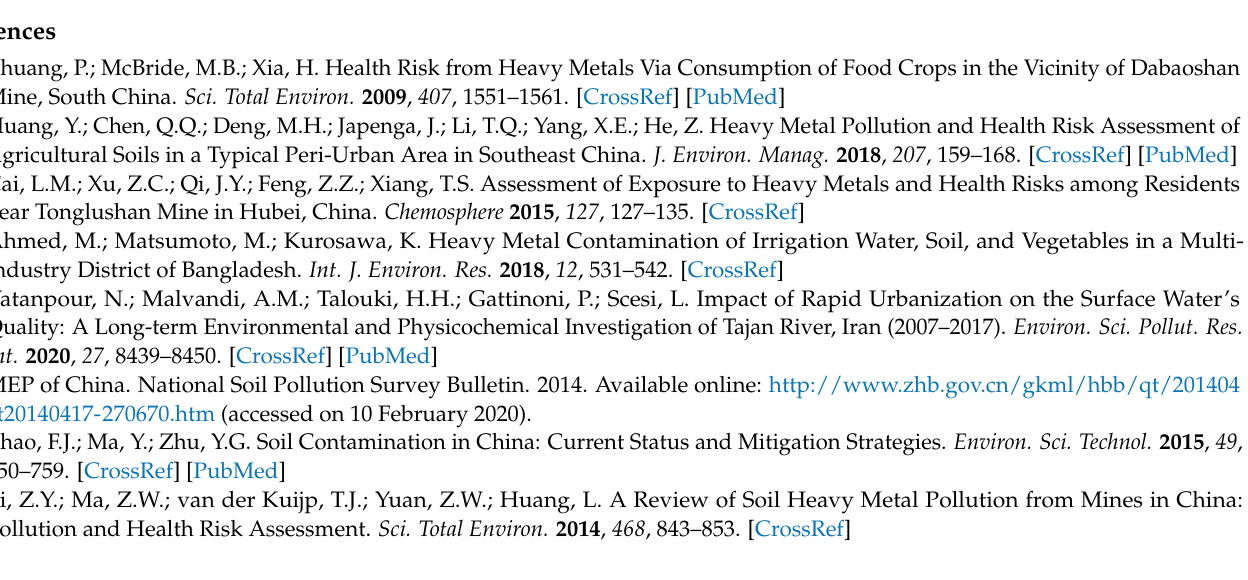
index. Table S2: Concentration (mg/kg, Fresh weight) of heavy metals in the foodstuffs of the four categories of vegetable gardens. Table S3: The assessment criteria in edible parts of different vegetables (mg/kg). Table S4: Principal component analysis for heavy metals of soils. Table S5: Indices of non-carcinogenic risk for children. Figure S1: Potential ecological risk index (RI) of single element in the four zones: (a) Non-ferrous metals smelter; (b) Abandoned copper mine; (c) Limestone quarry; (d) Iron mine. Figure S2: Spatial distribution pollution levels of Igeo-Cu in the four zones: (a) Non-ferrous metals smelter; (b) Abandoned copper mine; (c) Limestone quarry; (d) Iron mine. Figure S3: Spatial distribution pollution levels of Igeo-Cr in the four zones: (a) Non-ferrous metals smelter; (b) Abandoned copper mine; (c) Limestone quarry; (d) Iron mine. Figure S4: Spatial distribution pollution levels of Igeo-Pb in the four zones: (a) Non-ferrous metals smelter; (b) Abandoned copper mine; (c) Limestone quarry; (d) Iron mine. Figure S5: Spatial distribution pollution levels of Igeo-As in the four zones: (a) Non-ferrous metals smelter; (b) Abandoned copper mine; (c) Limestone quarry; (d) Iron mine. Figure S6: Correlation coefficients of heavy metals between soils and foodstuffs. Figure S7: Principal component analysis for heavy metals of soils in the four zones. Figure S8: Cluster analysis (CA) results for five heavy metals of soils (a) Non-ferrous metals smelter; (b) Abandoned copper mine; (c) Limestone quarry; (d) Iron mine. Figure S9: The health risk contribution rates of five different elements in the four